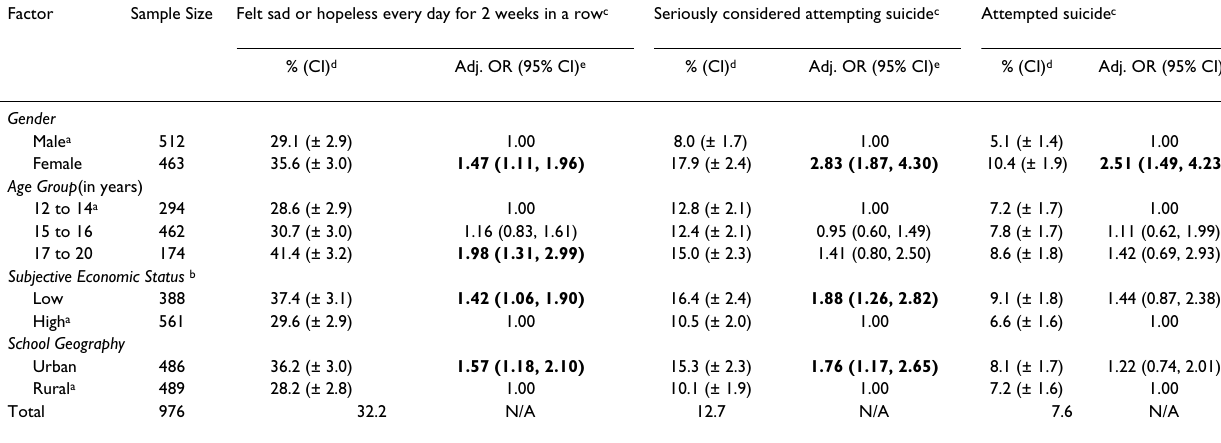
Table 3: Prevalence of depressive symptoms and suicidal ideation among eighth & ninth grade secondary students attending public schools in a central region of El Salvador by socio-demographic characteristics, 1999 Factor Sample Size Felt sad or hopeless every day for 2 weeks in a row